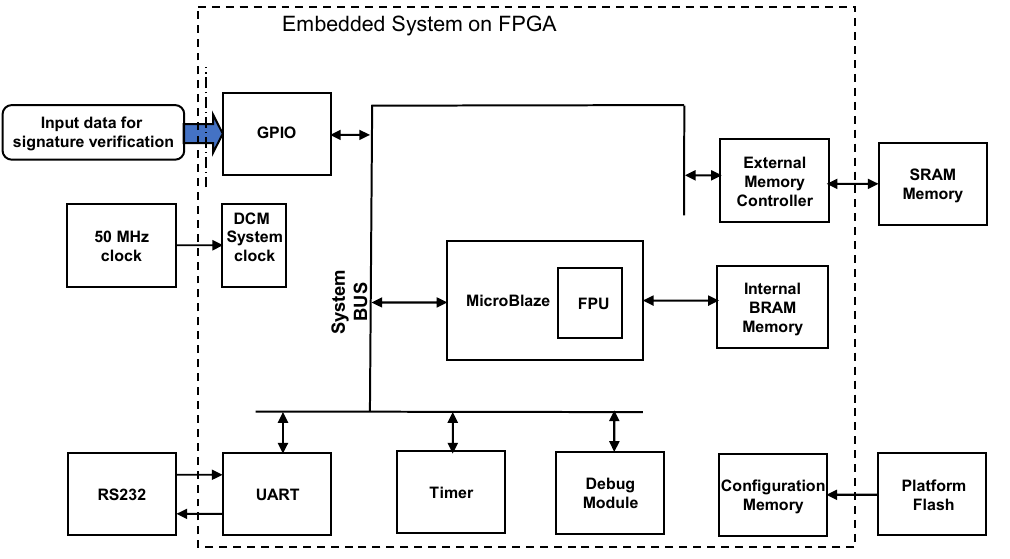
Figure 4. Overview of the embedded system.